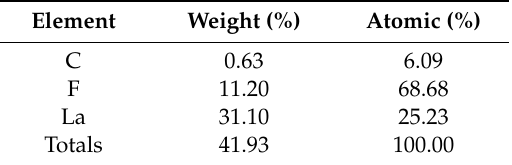
Table 4. Elemental analysis before Fe x O y NP loading.